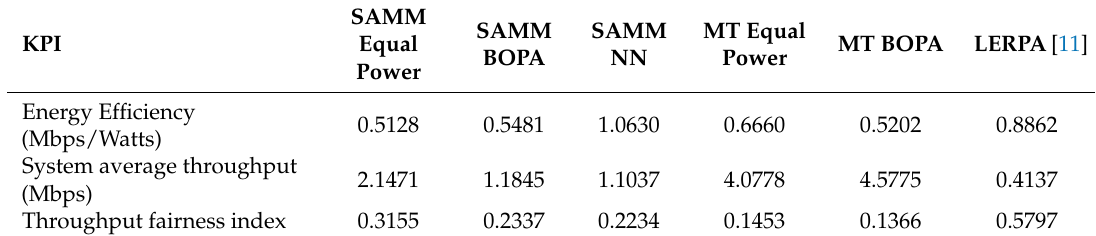
Figure 22. The system energy efficiency with neural network for SAMM which is trained on waterfilling based power allocation among users and BOPA based power allocation among subchannels along with LERPA of [11] in a multiple relays scenario. Table 3 summarizes simulation results. Table 3. Simulation